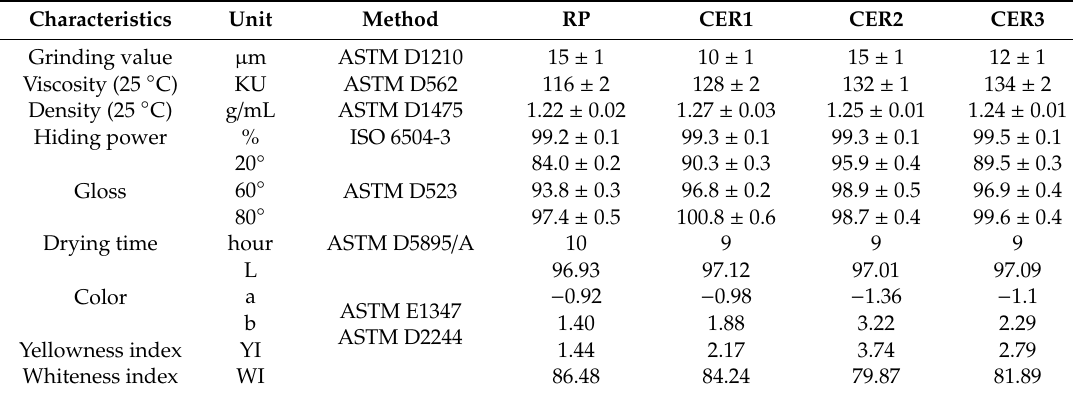
Table 2. Physical properties of coatings according to standard test methods.